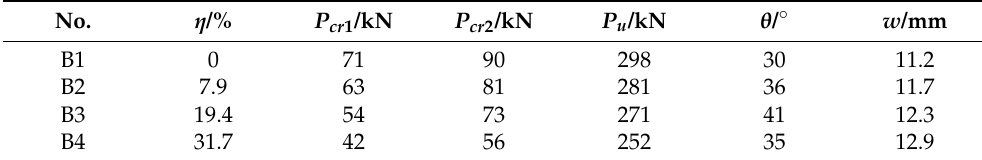
Table 3. Main test